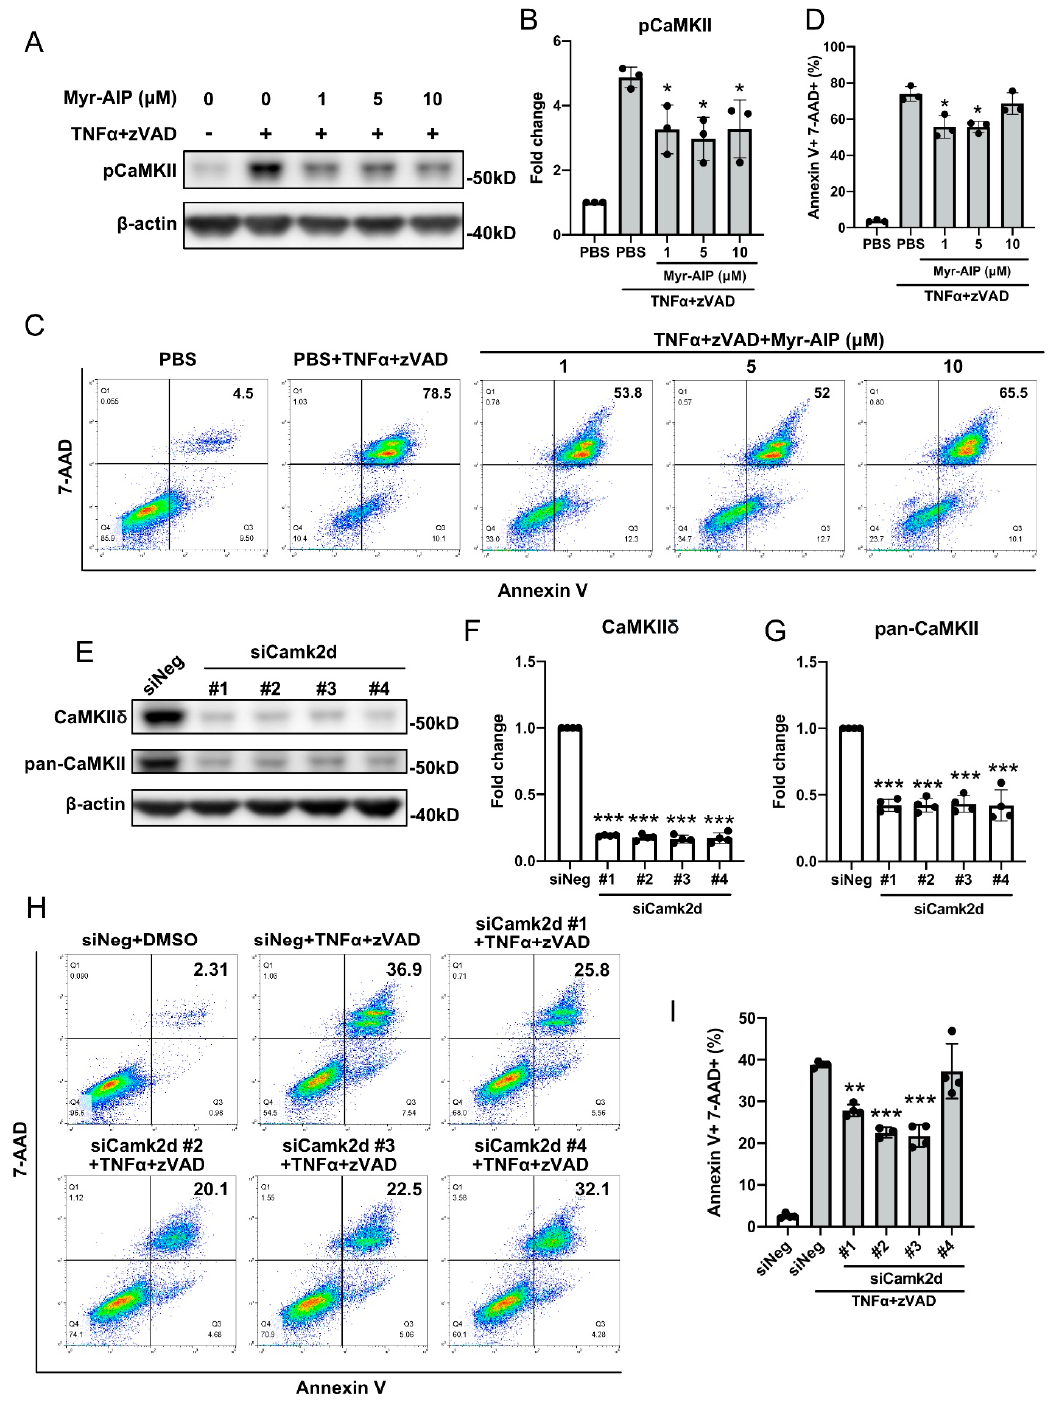
Figure 4. CaMKII is partially required for SMC necroptosis. ( A – D ) MOVAS cells were pretreated with indicated doses